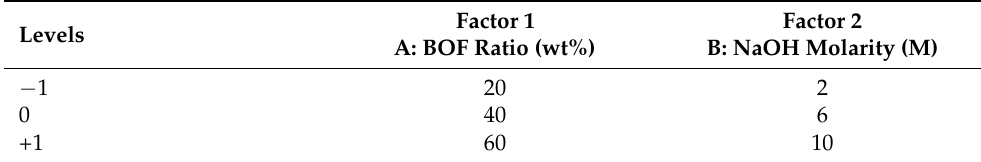
Table 3. Details of experimental mix design.